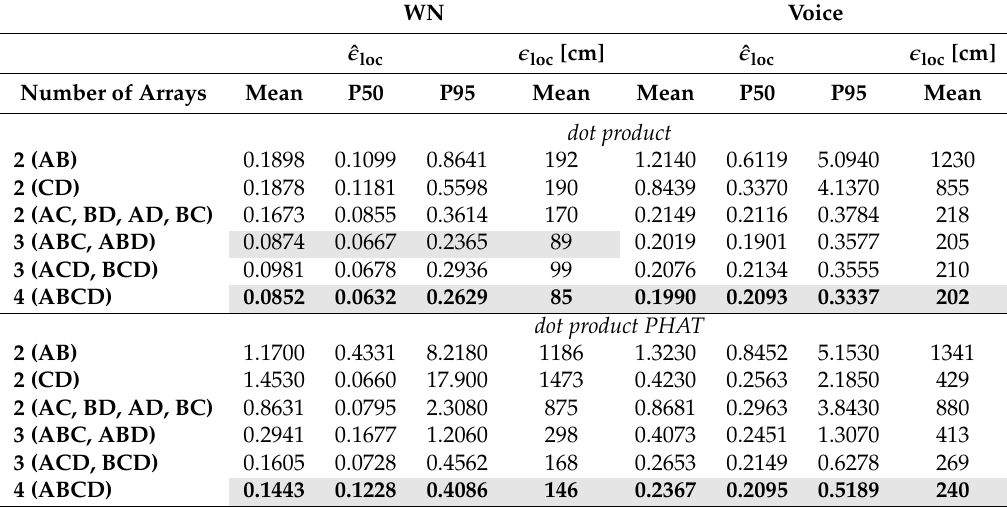
Table 6. ˆ (cid:101) loc and mean (cid:101) loc assessment of the triangulation algorithm for different array combinations, calculation methods and sounds. The highlighted rows list the best performing array combinations.